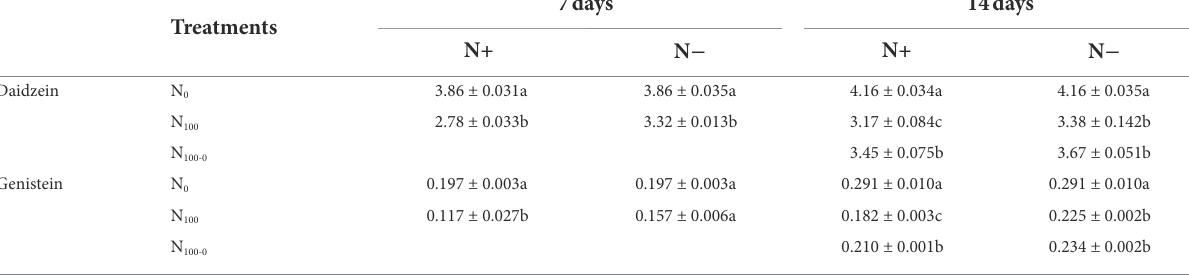
TABLE 3 Concentrations of daidzein and genistein in dual-root soybean roots (mg/g DW).